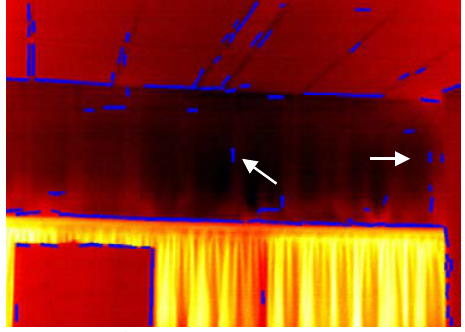
Figure 10. Result of the line segment detector algorithm applied to one of the thermographies. Detected lines are shown in blue; the white arrows mark the lines detected due to changes in radiometry caused by changes in temperature.